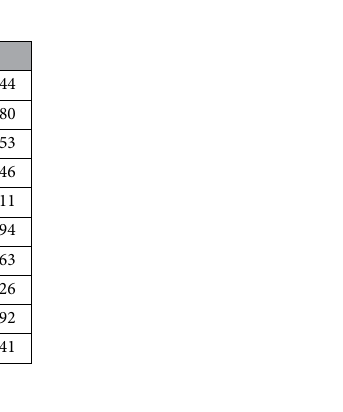
Table 3. Comparison of postoperative short-term